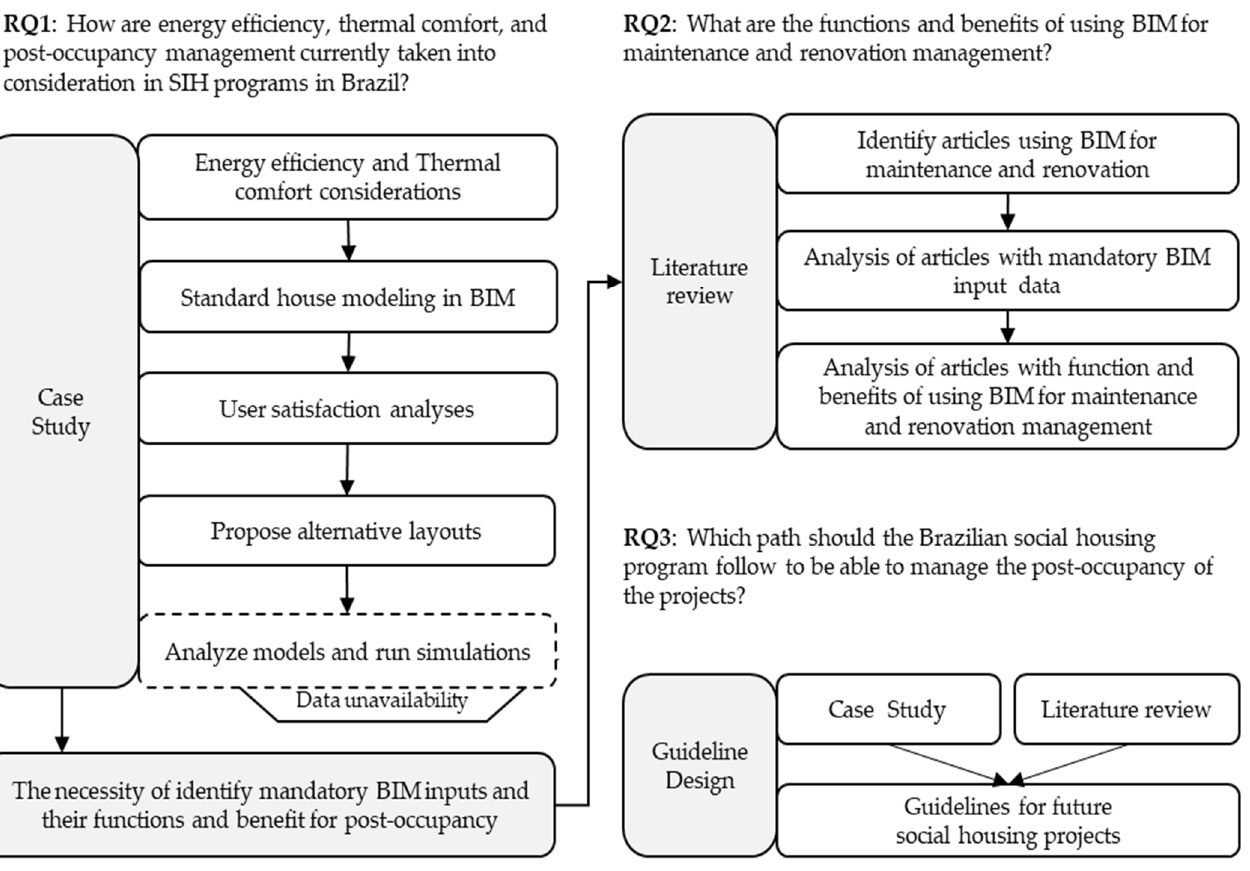
Figure 1. Study workflow diagram.